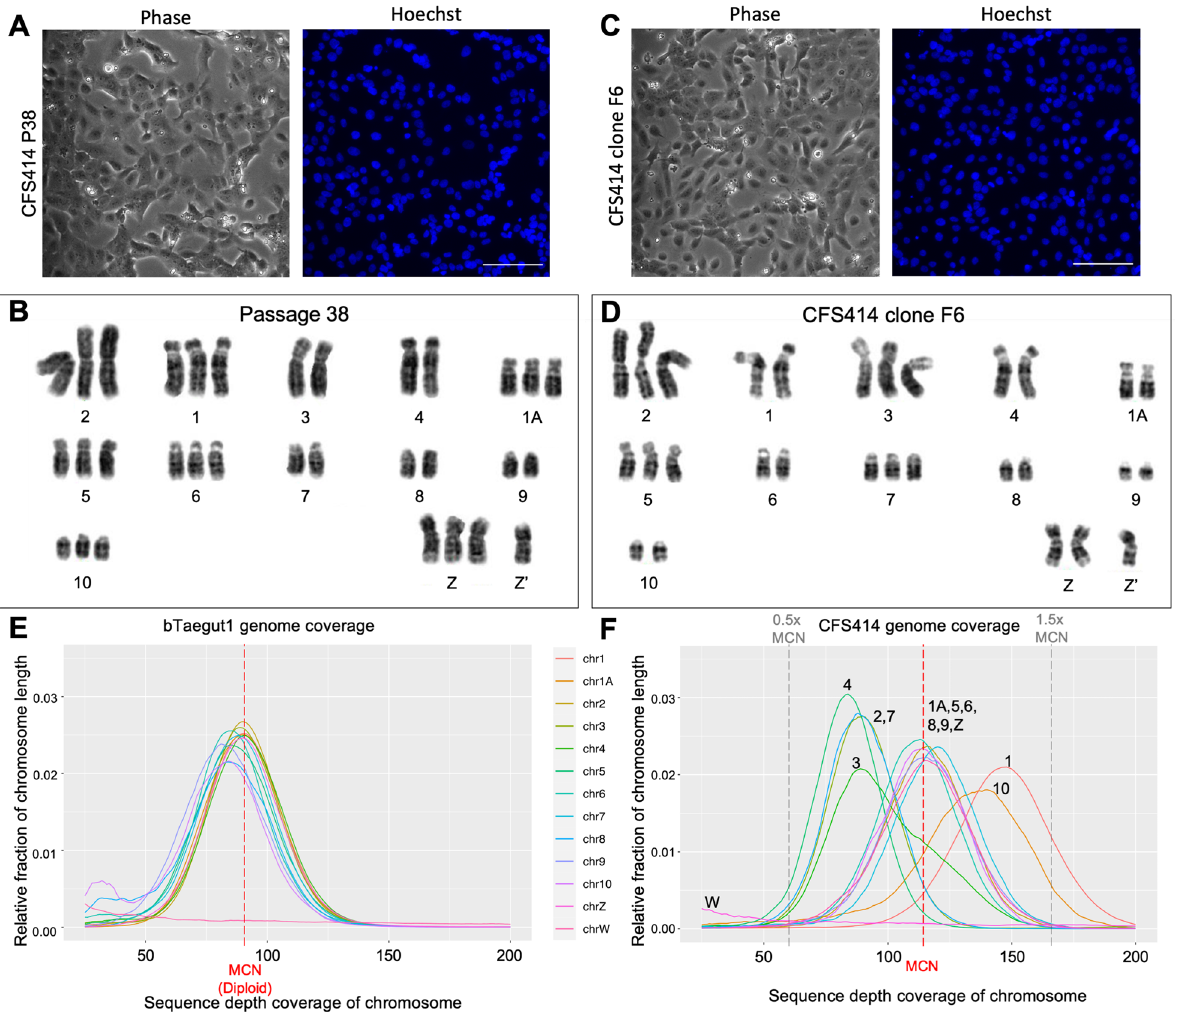
Figure 2. CFS414 chromosome copy numbers are variable. ( A, C ) Phase contrast images and accompanying Hoechst 33,342 nuclear stain images of ( A ) passage 38 and ( C ) CFS414 clone F6 cells derived by flow cytometry. ( B, D ) Corresponding Giemsa-stained macrochromosomes for ( B ) Passage 38 and ( D ) F6 cells. Chromosomes are arranged and numbered by size, with genome assembly chromosome numbers listed underneath each pair as identified through linkage-mapping from previous studies 31,32 . Trisomies are present for many chromosomes, with variability across cells. Note presence of mutant Z chromosome (Z ′ ) in all karyotypes. See Supplementary Fig. 2 for further karyotype spreads. ( E ) Coverage peaks from the bTaegut1 male zebra finch genome, showing a single grouping of chromosomes at the MCN (the red dotted line; coverage 88.2). ( F ) Relative coverage for each chromosome in CFS414 cells. Distributed peaks suggest cell population-wide copy number differences b etween chromosomes. The flanking grey lines representing 0.5 × and 1.5 × the MCN for reference. Note the CFS414 MCN is not necessarily representative of diploid chromosome pairs. See Supplementary Fig. 3 for individual chromosome coverage